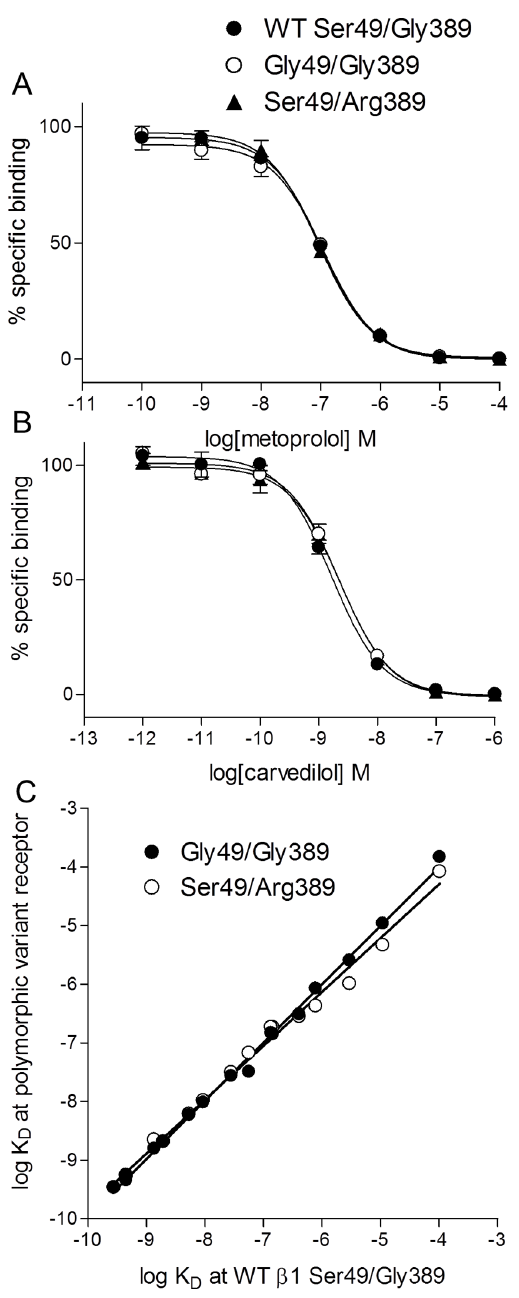
Figure 1. Inhibition of 3 H-CGP 12177 binding at the wildtype receptor and polymorphic variants. Inhibition of 3 H-CGP 12177 specific binding by A metoprolol and B carvedilol in wildtype (WT), Gly49/Gly389 cells and Ser49/Arg389 cells. Non-specific binding was determined by 10 m M propranolol. The concentration of 3 H-CGP 12177 present in each case was 0.96 nM. Data points are mean 6 s.e.mean of triplicate determinations and these single experiments are representative of 6 separate experiments in each case. C Correlation plot for the affinity of all the ligands from Table 1 for the wildtype (x-axis) and polymorphic variants (y-axis). There is a strong correlation between the affinity measurements made in the wildtype and those measured in either the Gly49/Gly389 receptor (R 2 =1.00, slope 0.99 6 0.01) and the Ser49/Arg389 receptor (R 2 =0.99, slope=0.92 6 0.02). This demonstrates that ligands had very similar affinity for all three receptors.